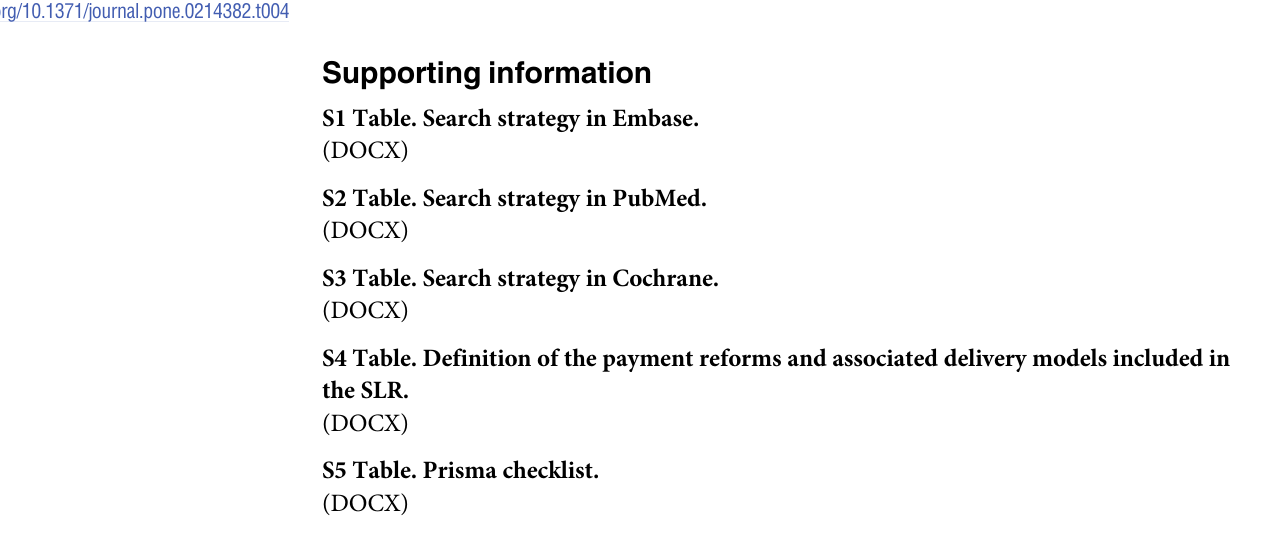
S5 Table. Prisma checklist.